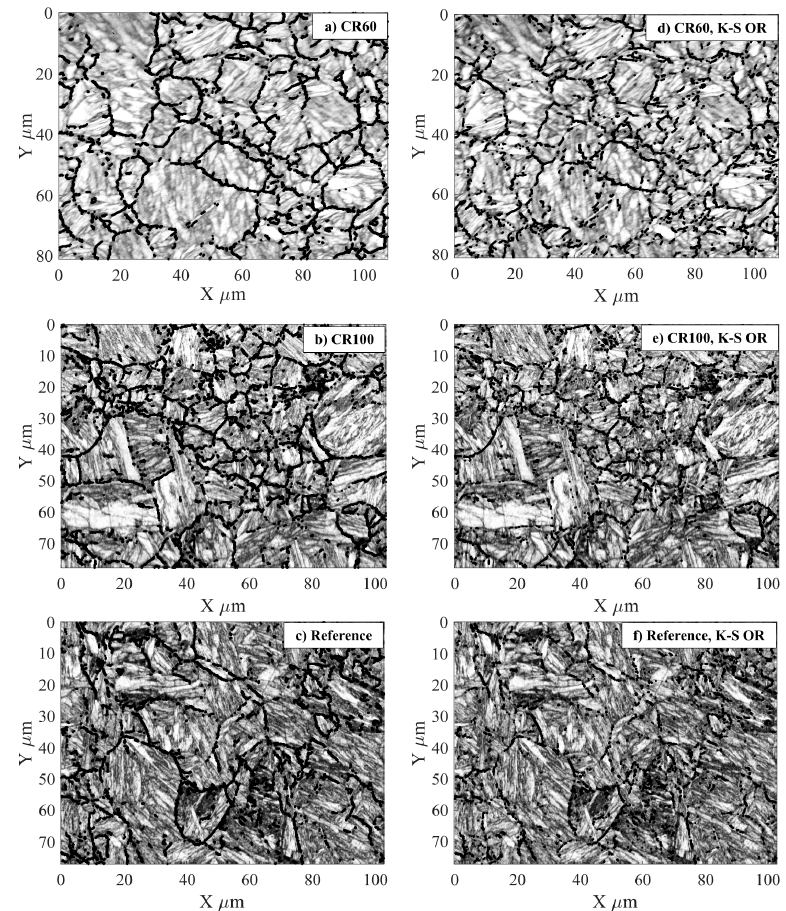
Figure 5. The martensite boundaries that are marked with black colour in the band contrast image represents parent austenite boundaries. ( a – c ) show misorientations between 15°–48°; ( d – f ) show the Kurdjumov-Sachs orientation relationship (±10°).